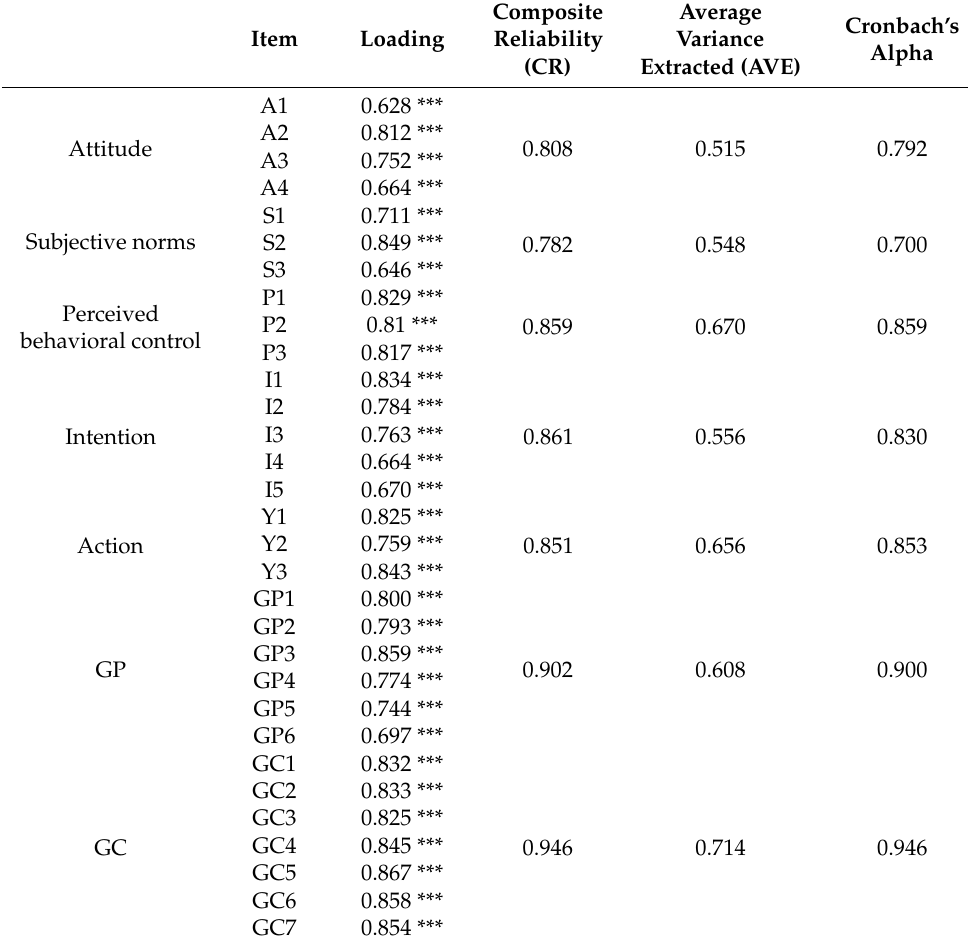
Table 2. Construct measures, items, loadings, reliability and validity.